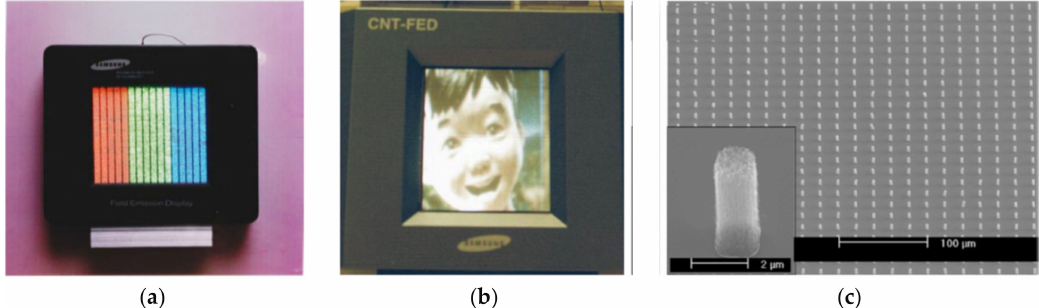
Figure 1. Examples of the field-emission displays (FED): ( a ) the emitting color (red–green–blue) phosphor columns image of fully sealed SWNT-FED presented by Samsung (reprinted with permission from [65]); ( b ) further results from Samsung presenting the color image (reprinted with permission from [66]); and ( c ) a scanning electron microscopy (SEM) image of CNT arrays for the FED by Philips (reprinted with permission from